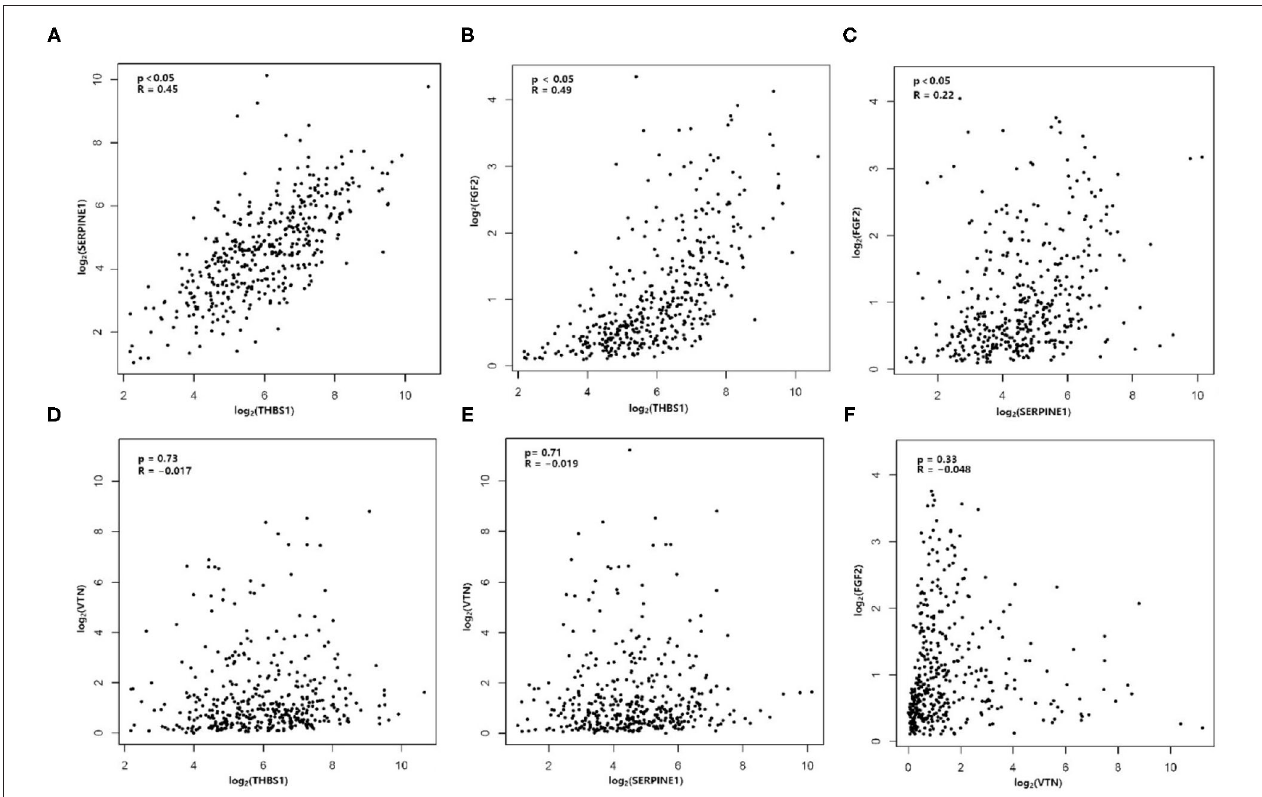
FIGURE 7 | Correlation analysis is shown for (A) THBS1 and SERPINE1, (B) THBS1 and FGF2, (C) SERPINE1 and FGF2, (D) THBS1 and VTN, (E) SERPINE1 and VTN, and (F) VTN and FGF2.